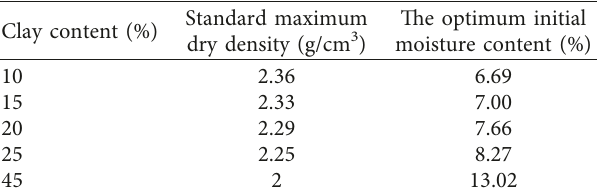
Figure 1: Gradation curve. Table 1: Results of standard compaction